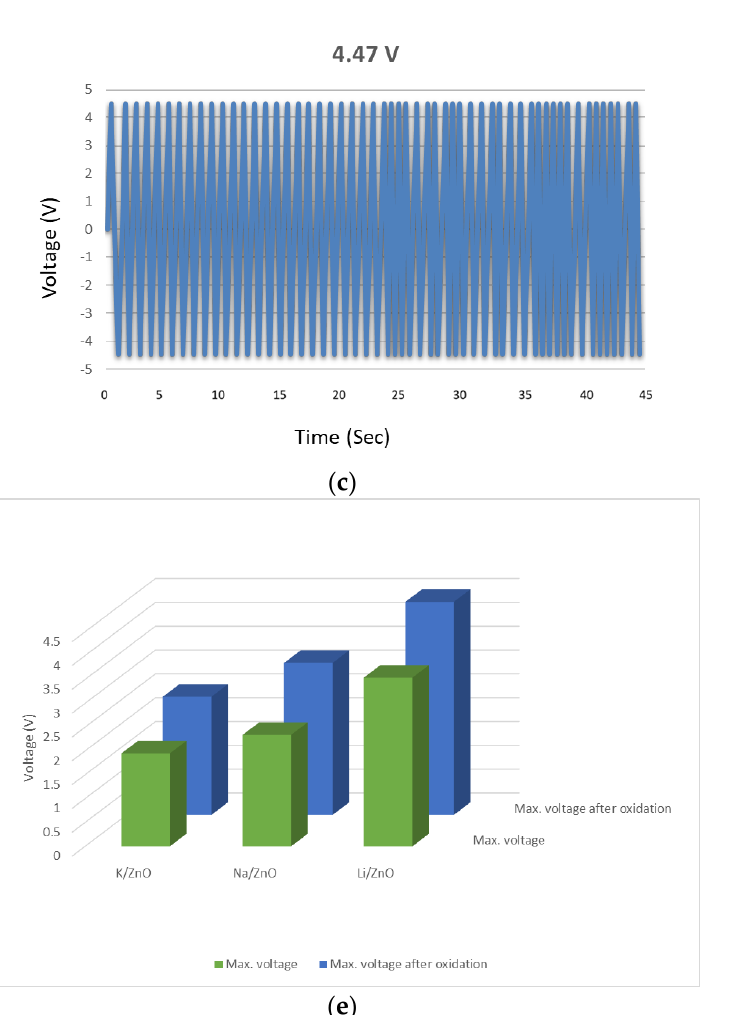
Figure 9. output voltage values generated by ZnO nanowires based VING oxidized for 5 h, ( a ) 6%K/ZnO, ( b ) 6%Na/ZnO, ( c ) 6% Li/ZnO, ( d ) voltage increment by changing load resistance, and ( e ) voltage comparison for all three cases with and without oxidation.